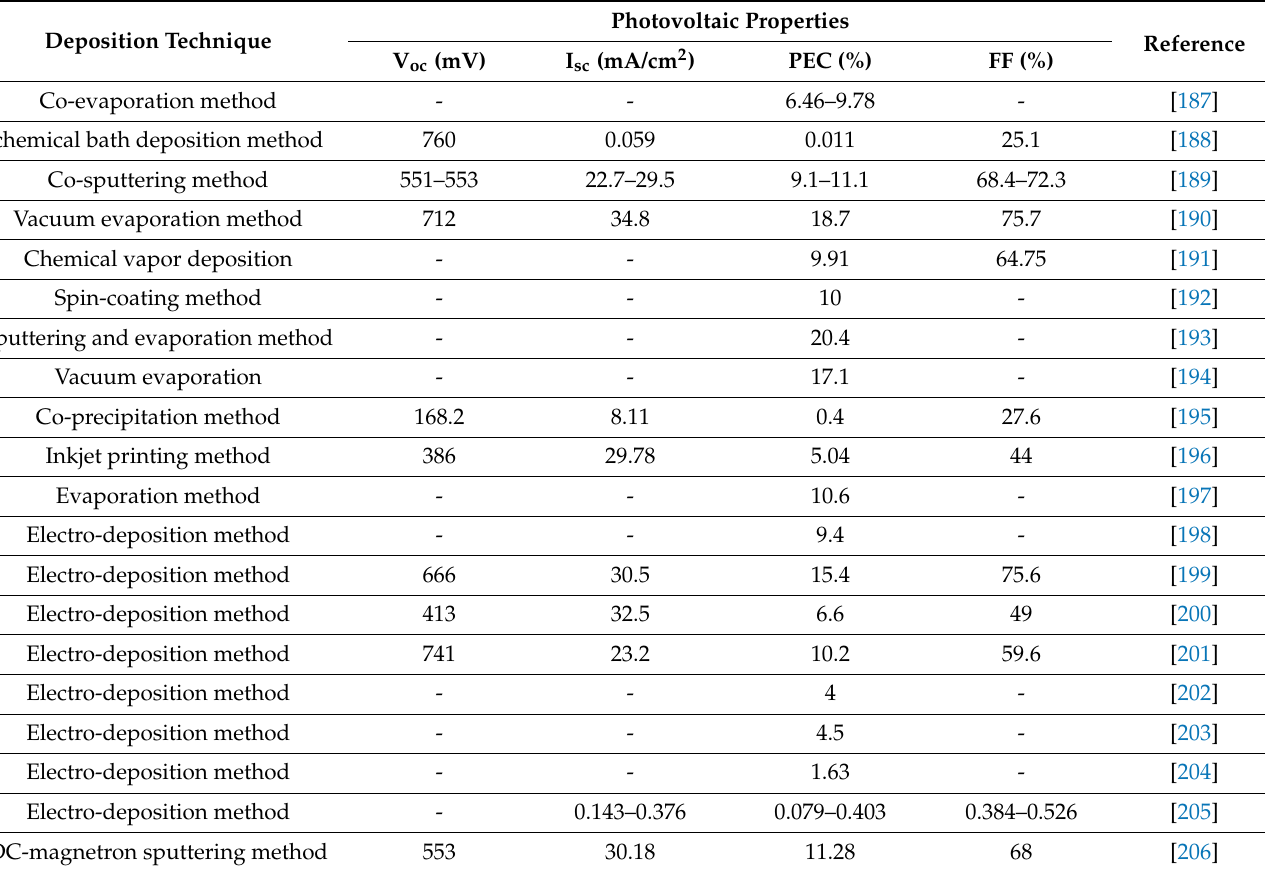
Table 3. The growth of CIGS films using various deposition methods and the photovoltaic